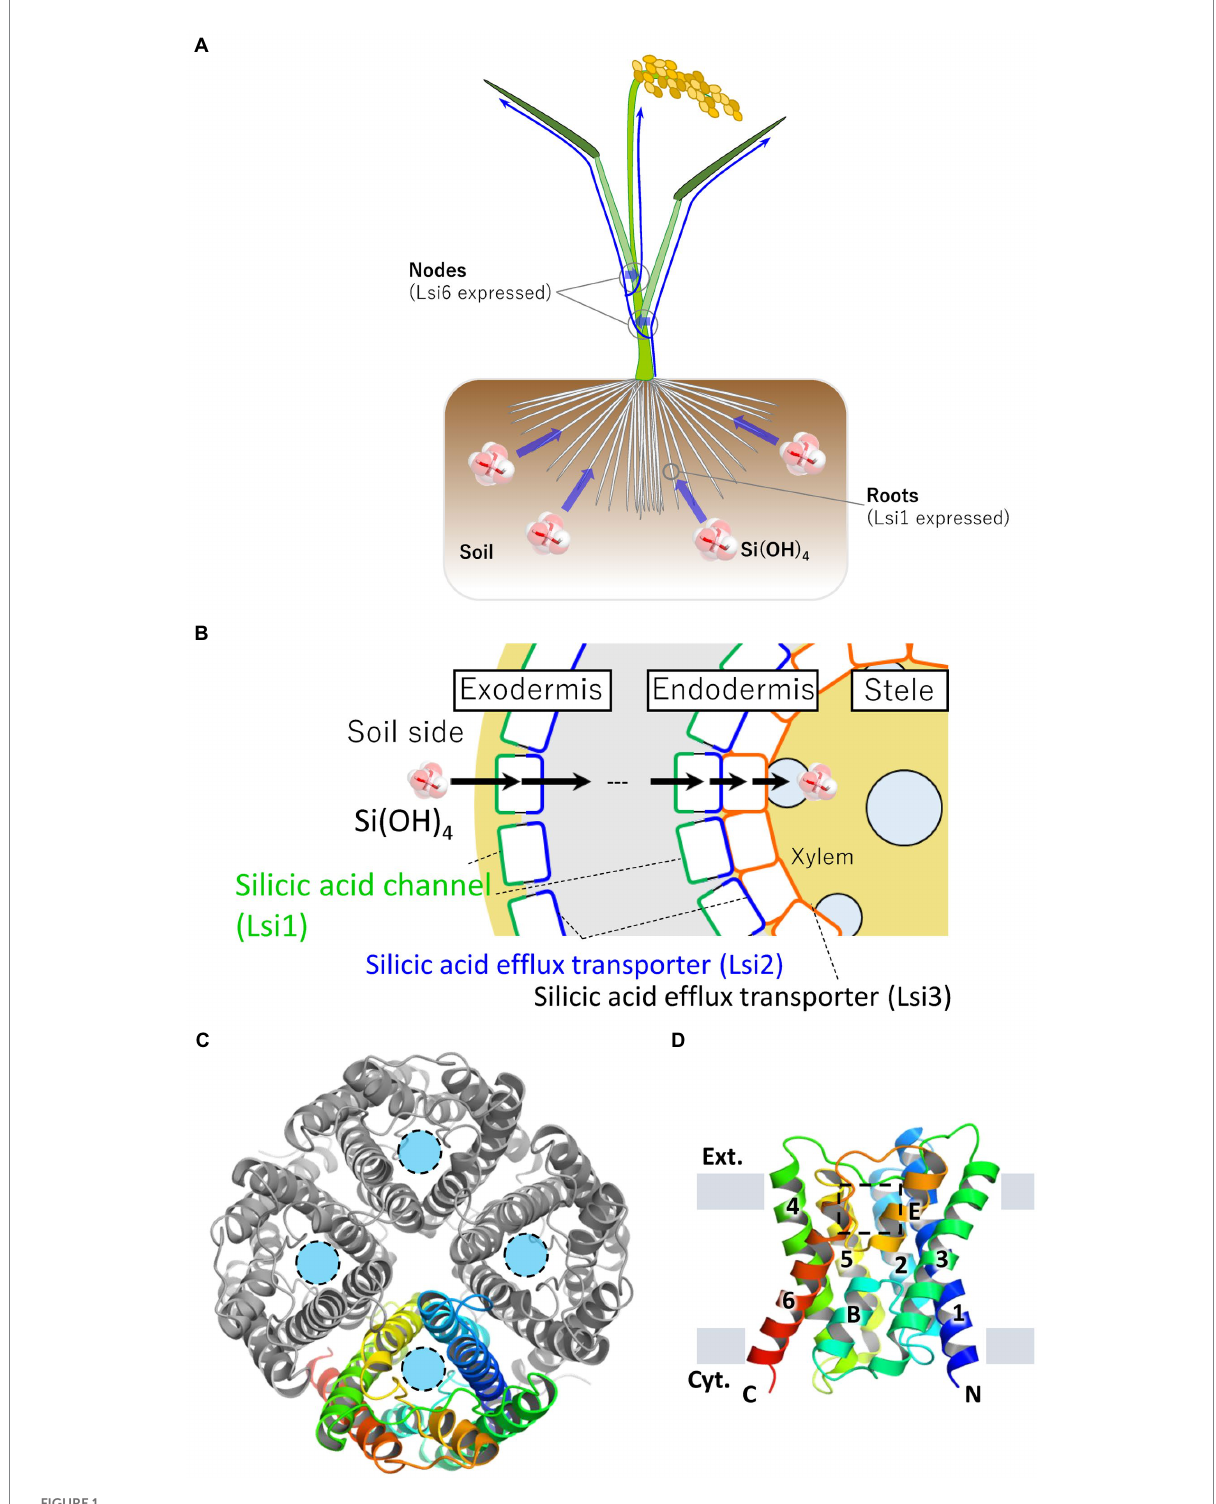
FIGURE 1 Localization of silicic acid transporters in rice and crystal structure of Lsi1. (A) Schematic representation of silicic acid absorption and distribution in rice plants. Rice roots take up silicic acid in the soil. Blue arrows indicate silicic acid migration. Silicic acid channel Lsi1 is mainly localized in the roots, and Lsi6 is localized in the nodes. Lsi1 and Lsi6 are involved in silicic acid absorption and distribution, respectively. (B) Schematic cross- section of a rice root. Lsi1, shown in the green line, is localized on the distal side of the cell membrane in the exodermis and endodermis. A silicic acid efflux transporter Lsi2 is shown in the blue line. Lsi2 is localized on the proximal side of the cell membrane in the exodermis and endodermis. Lsi3, shown in the orange line, is localized on the cell membrane in the pericycle. (C) The overall structure of the Lsi1 tetramer is viewed from